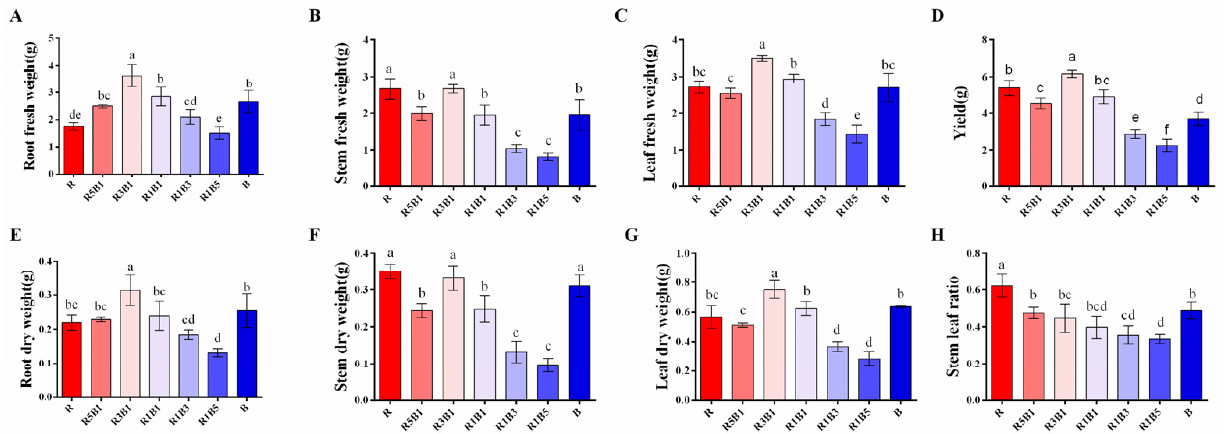
Figure 3. Fresh weight of each part of the plant ( A – C ), Yield: sum of shoot fresh weight ( D ), dry weight of